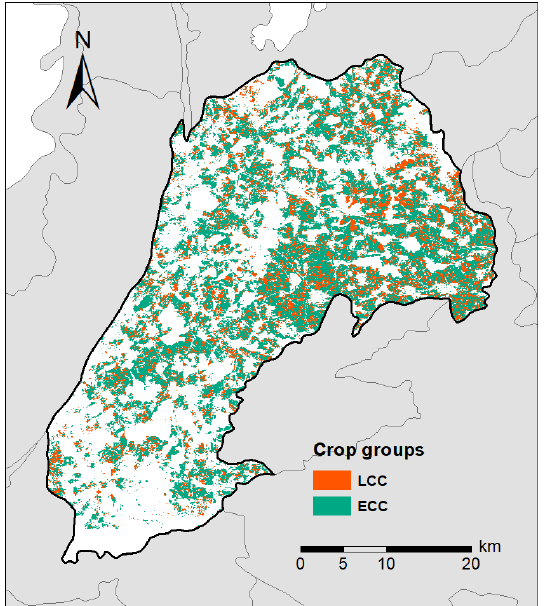
Figure 1. Map of early-covering (ECC) and late-covering crops (LCC) in Kraichgau region, southwestern